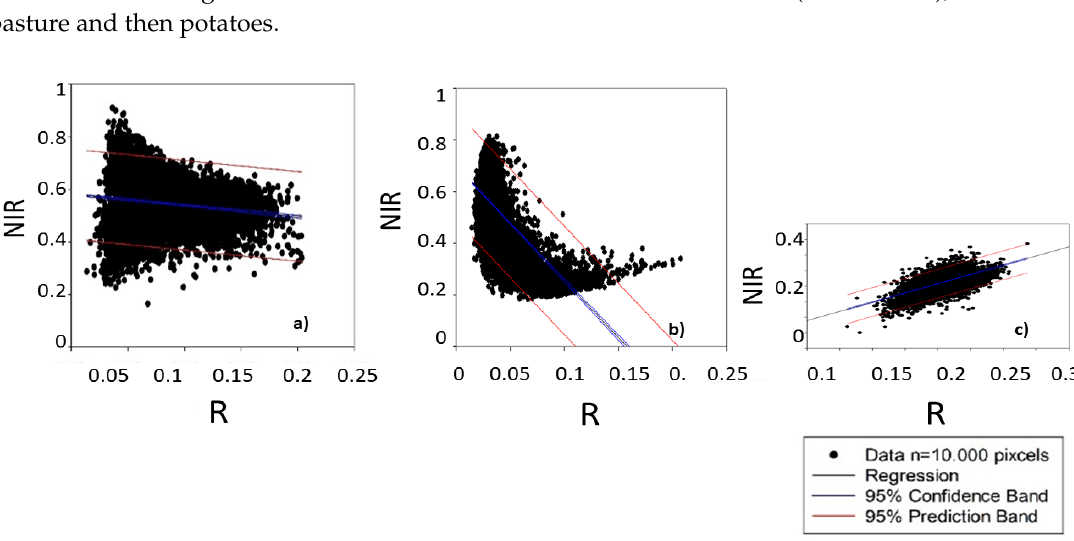
Table 2. NIR–red linear equations to obtain the M value to calculate the PDI at 4 cm.